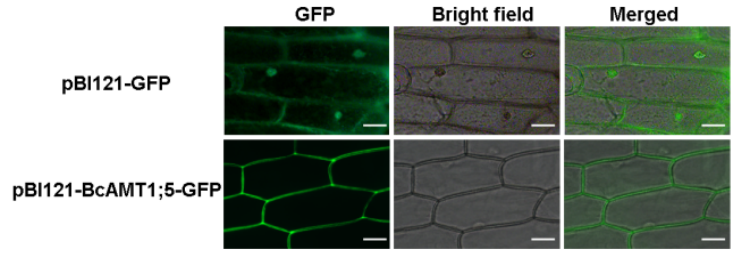
Figure 2. Subcellular localization of pBI121-GFP, pBI121-BcAMT1;5-GFP fusion proteins in onion epidermal cells. GFP: the green fluorescence images observed by fluorescence microscopy; bright field: the images observed by bright field microscopy; merged: the overlay of the two images of GFP and bright field. The scale bar is 50 μ m.